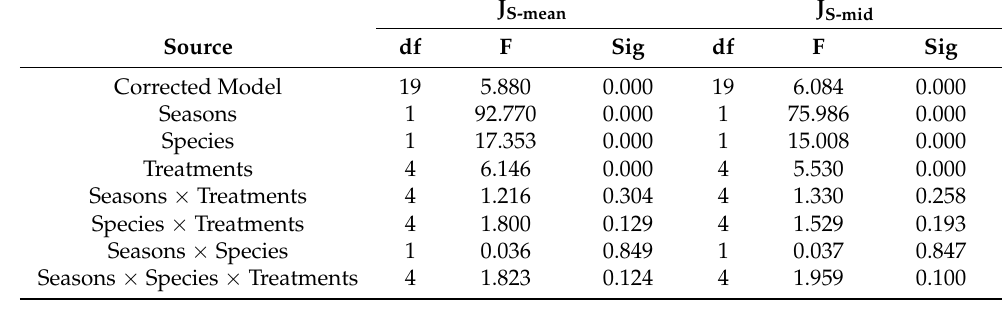
Table 1. ANOVA on the J S-mean and J S-mid .